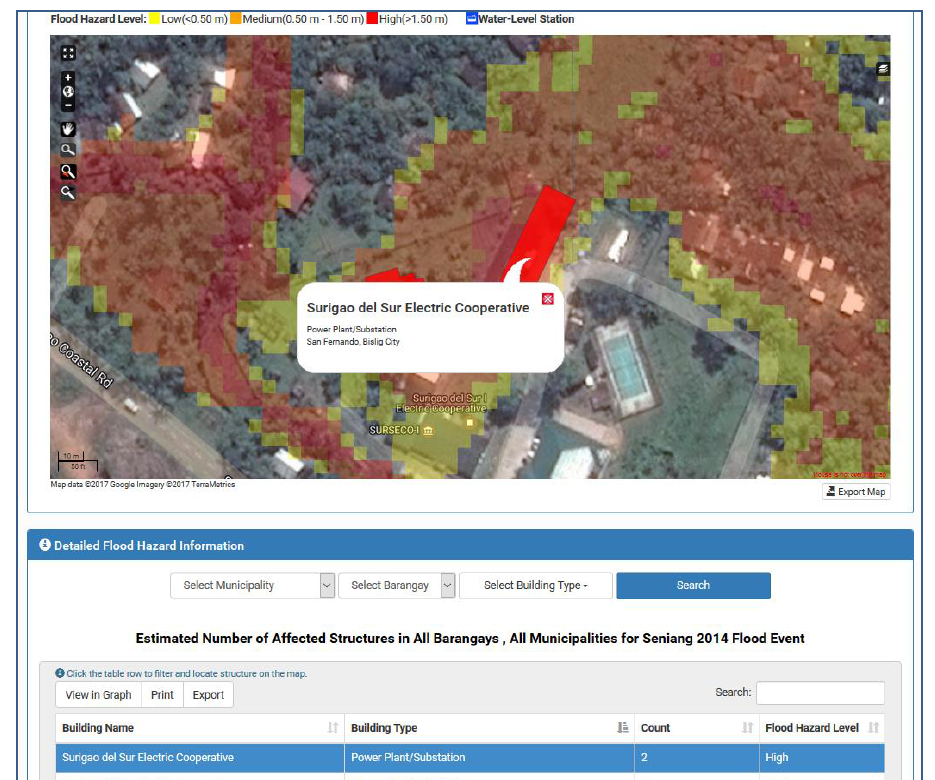
Figure 9. Map showing flood extent and hazard levels, including the location and description of the affected